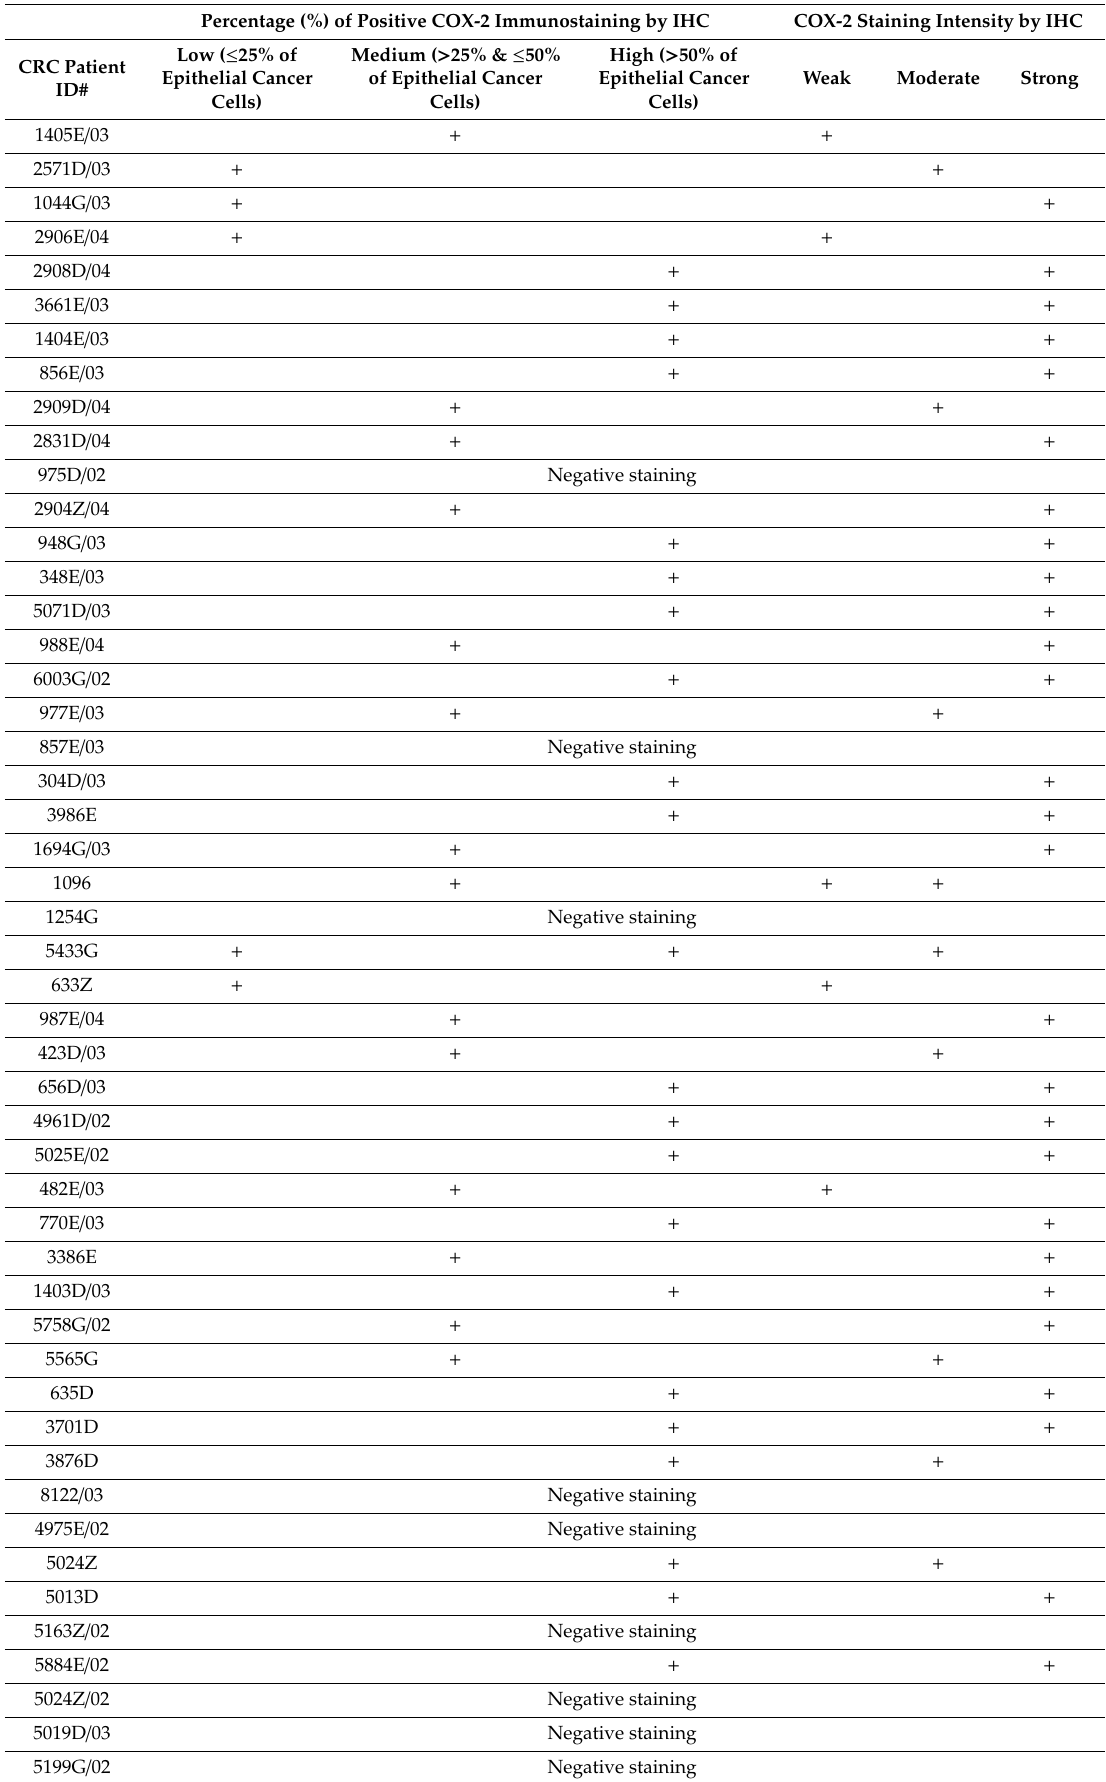
Table 1. COX-2 immunostaining in the CRC patient cohort (n =